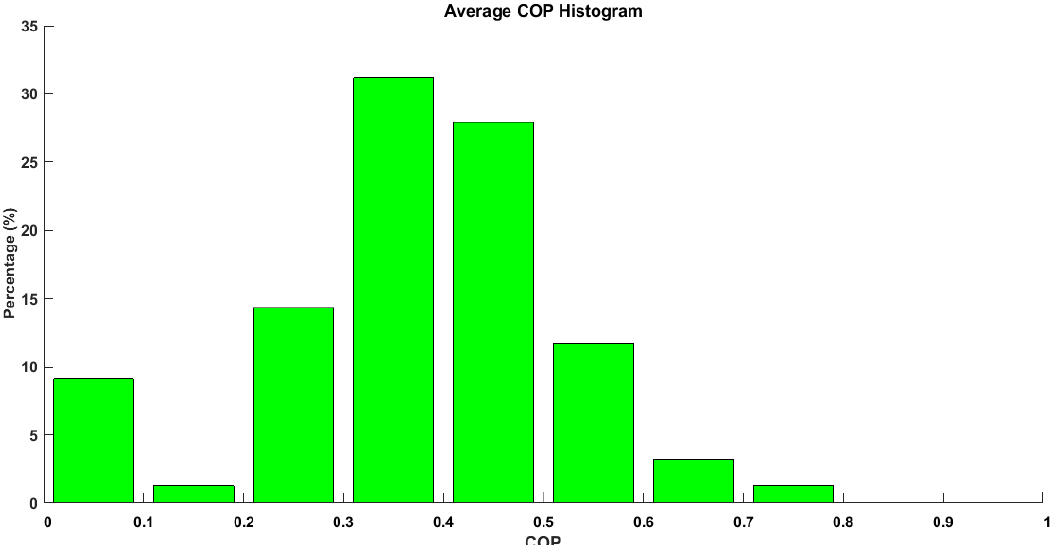
Figure 15. Average COP per cycle histogram.